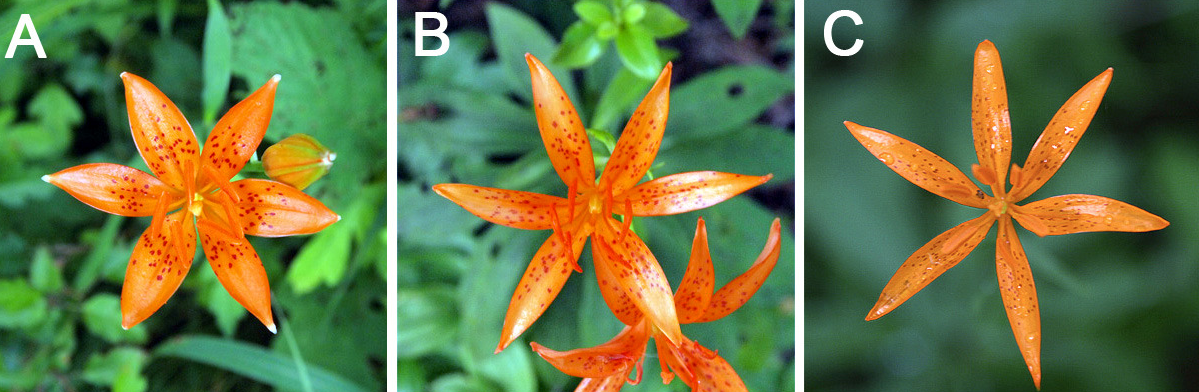
Fig. 1. Variation of flower morphology in L. tsingtauense found in different habitats. Flowers from A: short-wide type, B: normal type, and C: narrow